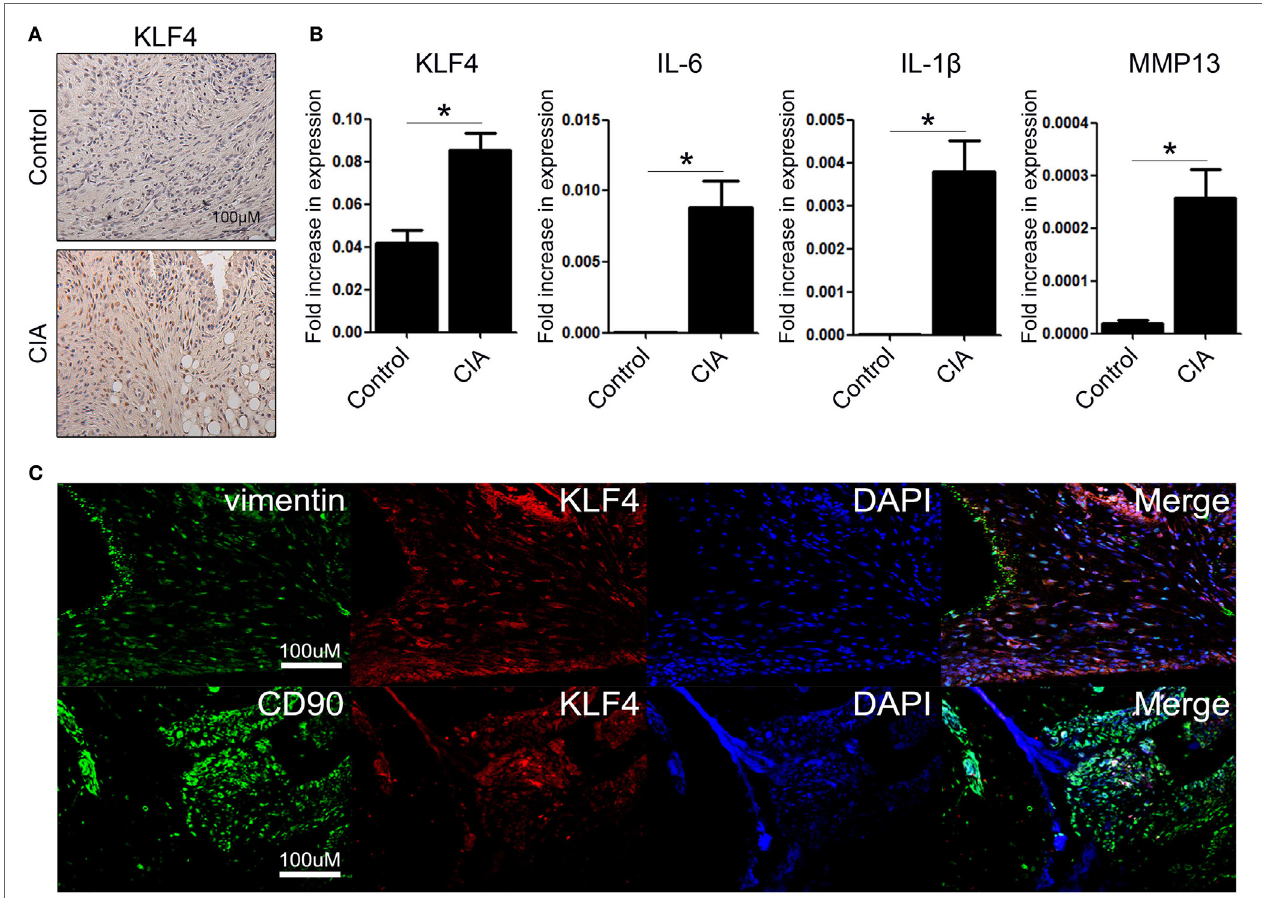
FigUre 1 | Kruppel-like factor (KLF) 4 is upregulated in joint tissue from collagen-induced arthritis (CIA) mouse. (a) Representative immunohistochemistry images of joint tissue sections from control and CIA mice stained with an anti-KLF4 antibody (red). Original magnification, 200 × . (b) Expression of mRNA encoding KLF4, interleukin (IL)-6, IL-1 β , and matrix metalloproteinase (MMP) 13 in murine fibroblast-like synoviocytes in response to lipopolysaccharide (LPS) (as measured by qRT-PCR). The concentration of LPS in the medium was 500 ng/ml. (c) Representative immunofluorescence assay images of tissue sections stained with anti-vimentin, anti-CD90, anti-KLF4 antibodies and DAPI (4 ′ ,6-diamidino-2-phenylindole). Original magnification, 200 × . Values in panel (b) are expressed as the mean ± SEM (* P <